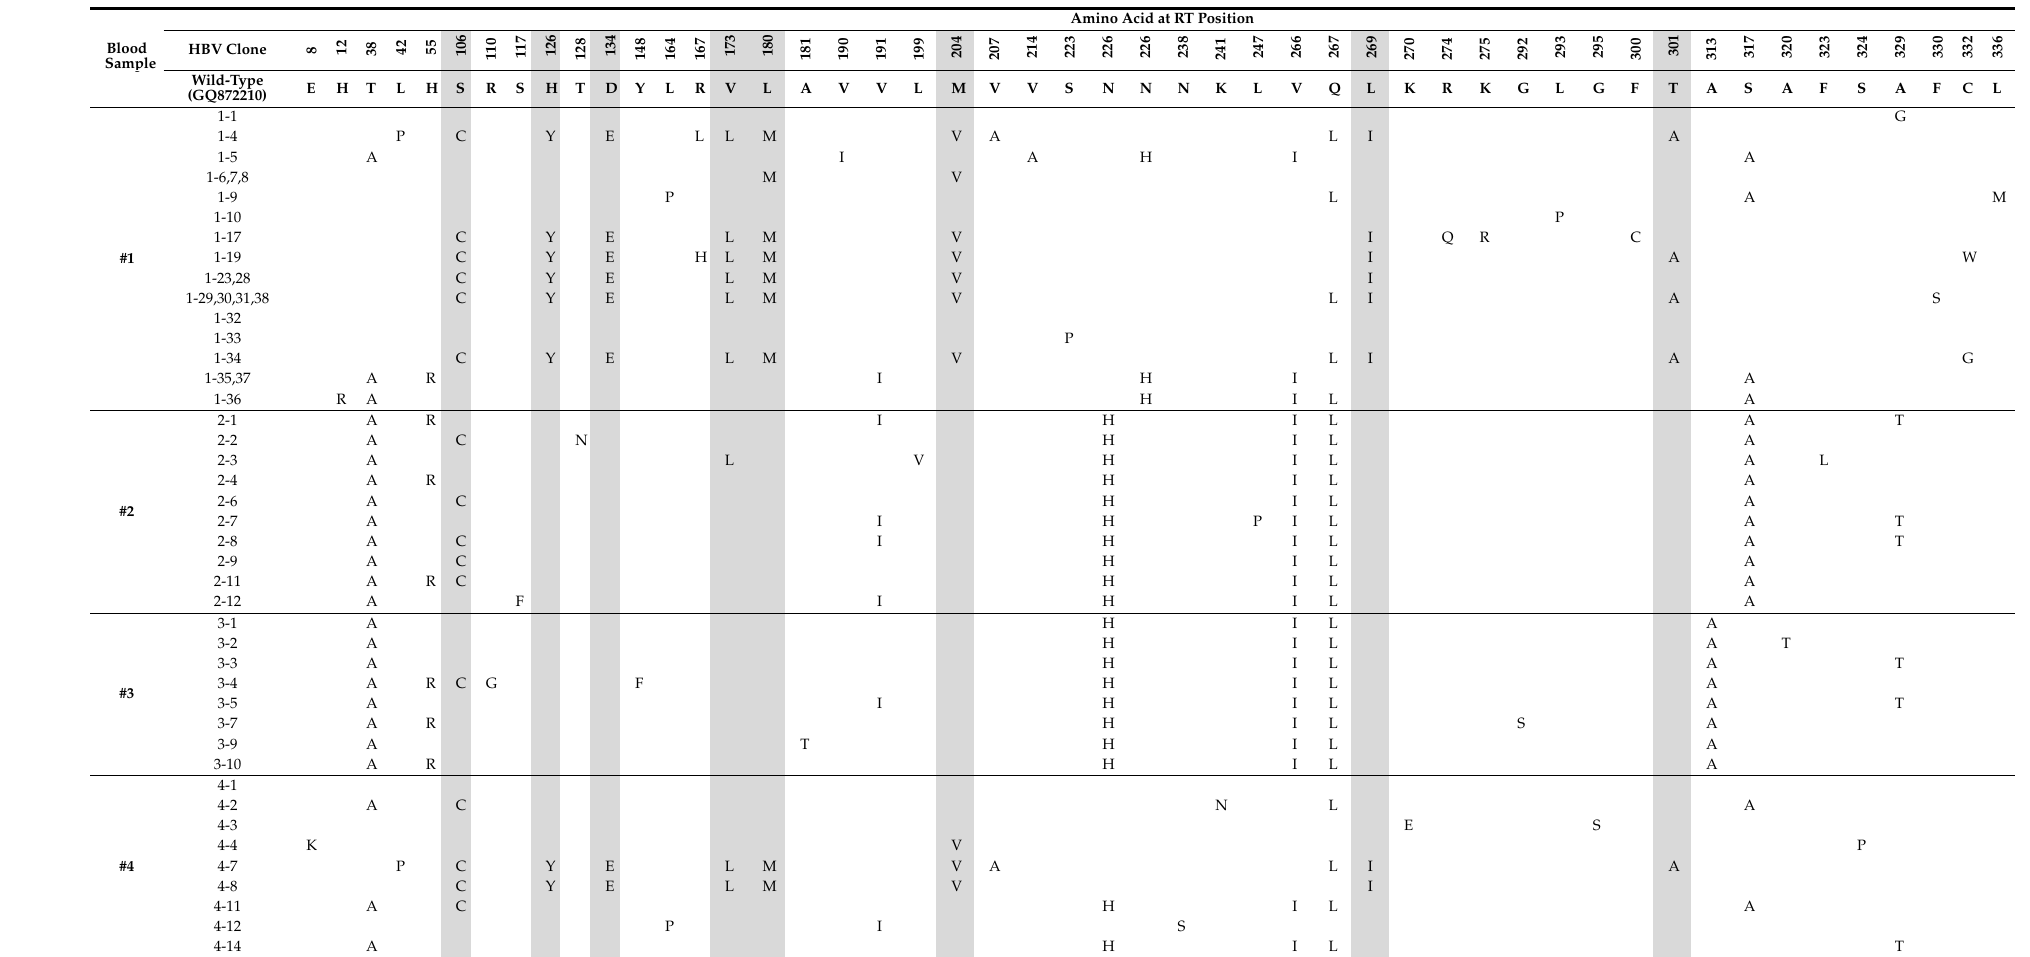
Table 1. Identification of HBV RT mutation isolated from a TDF-treated patient.